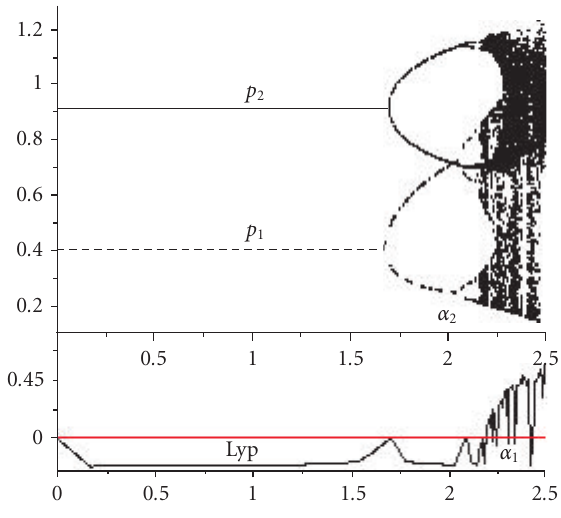
Figure 4.2 . Bifurcation diagram for α 2 = 0 . 4.